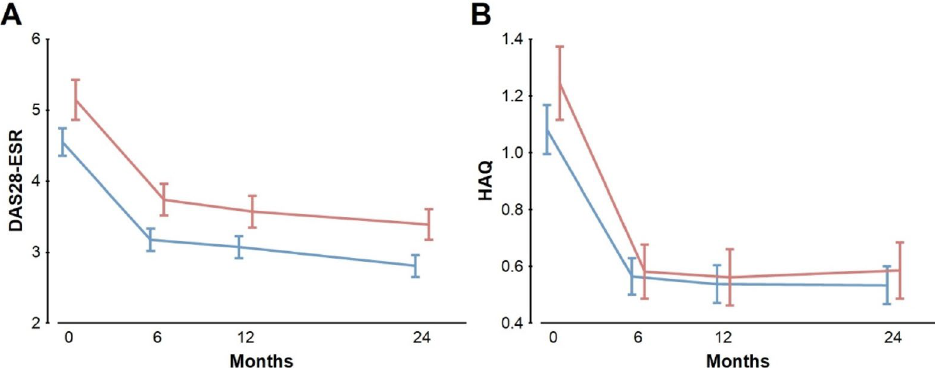
Figure 2. Persistent elevated DAS28-ESR but not HAQ in the EA ACarPA + patients with complete follow-up data. ( A ) DAS28-ESR means and 95% CI in the 380 patients with data at the four follow-up times. Differences at each point p < 7.5 × 10 –4 . ( B ) HAQ means and 95% CI in the 434 patients with full follow-up data. Differences were not significant. The ACarPA + patients are represented in red, whereas the ACarPA − patients are in blue.